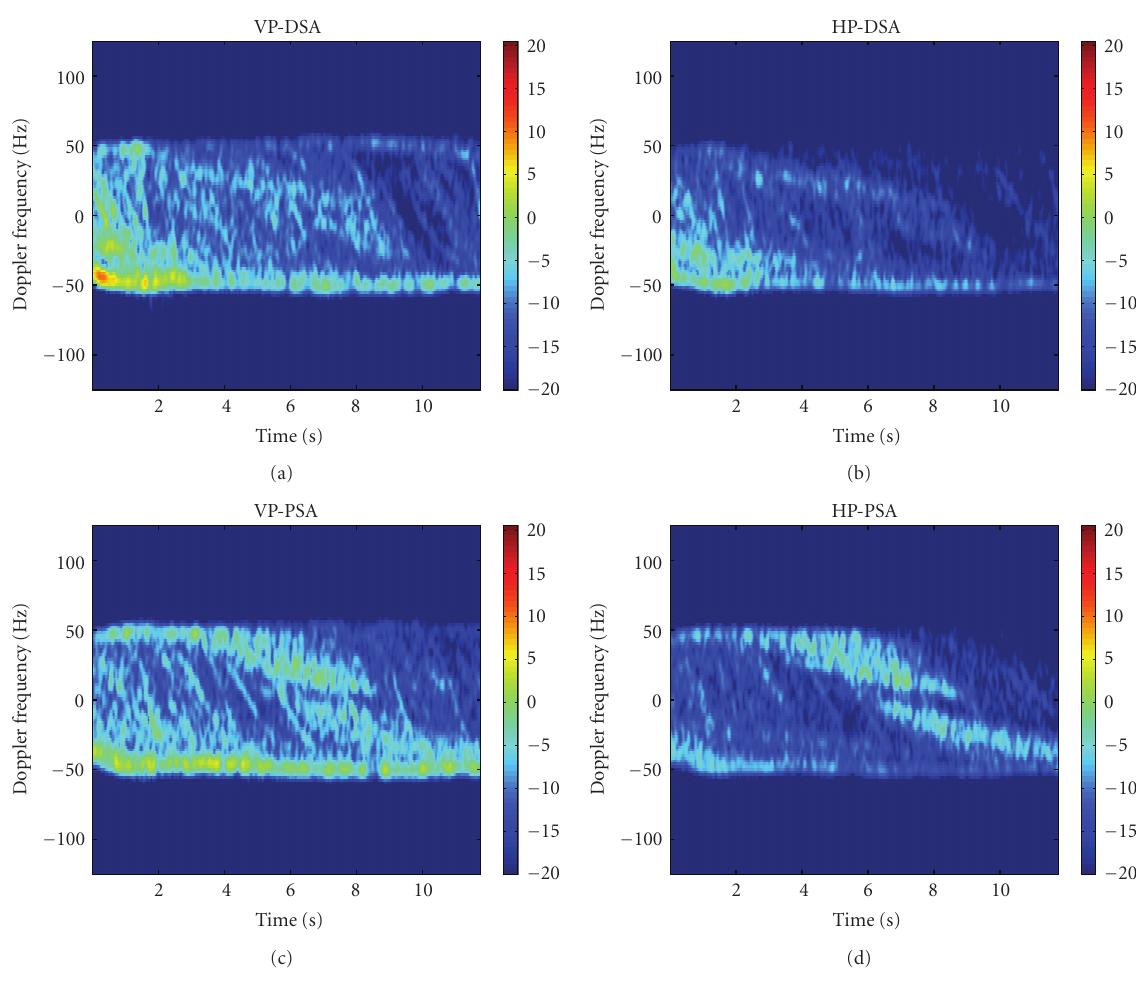
Figure 5: Doppler power (dB) spectra measured at the VP-DSA, HP-DSA, VP-PSA, and HP-PSA on Slater Street.